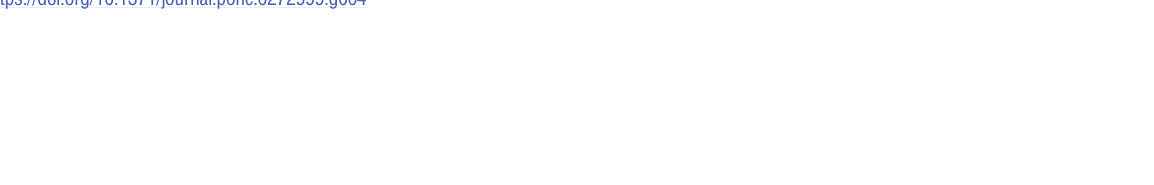
PLOS ONE | https://doi.org/10.1371/journal.pone.0272999 August 25,